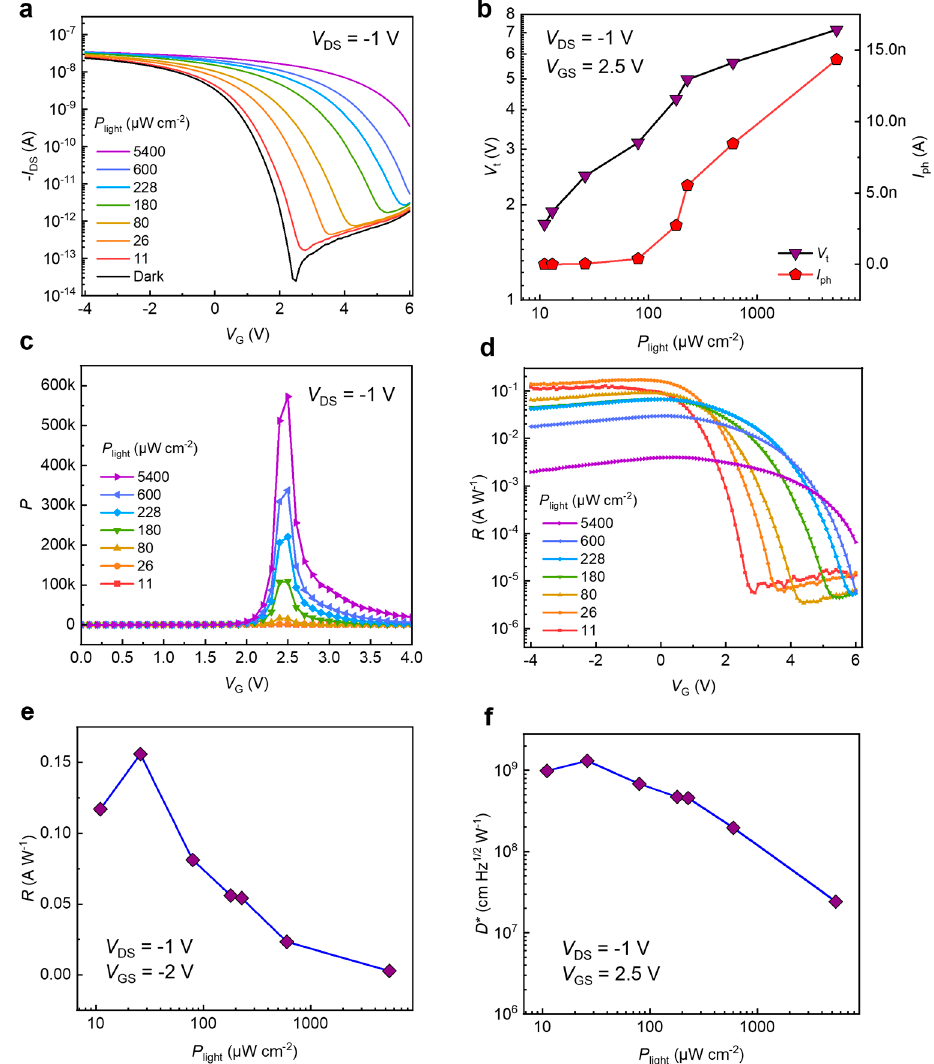
Figure 3. Photoresponse of the fully-printed OPTs. ( a ) Typical transfer curves of a fully printed OPT in the dark and under light illumination with various intensities. ( b ) Photocurrent and threshold voltage as a function of the light intensity. Photosensitivity ( c ) and photoresponsivity ( d ) as a function of gate voltage under different light intensities. Light intensity-dependent photoresponsivity ( e ) and specific detectivity ( f ) of the OPT.